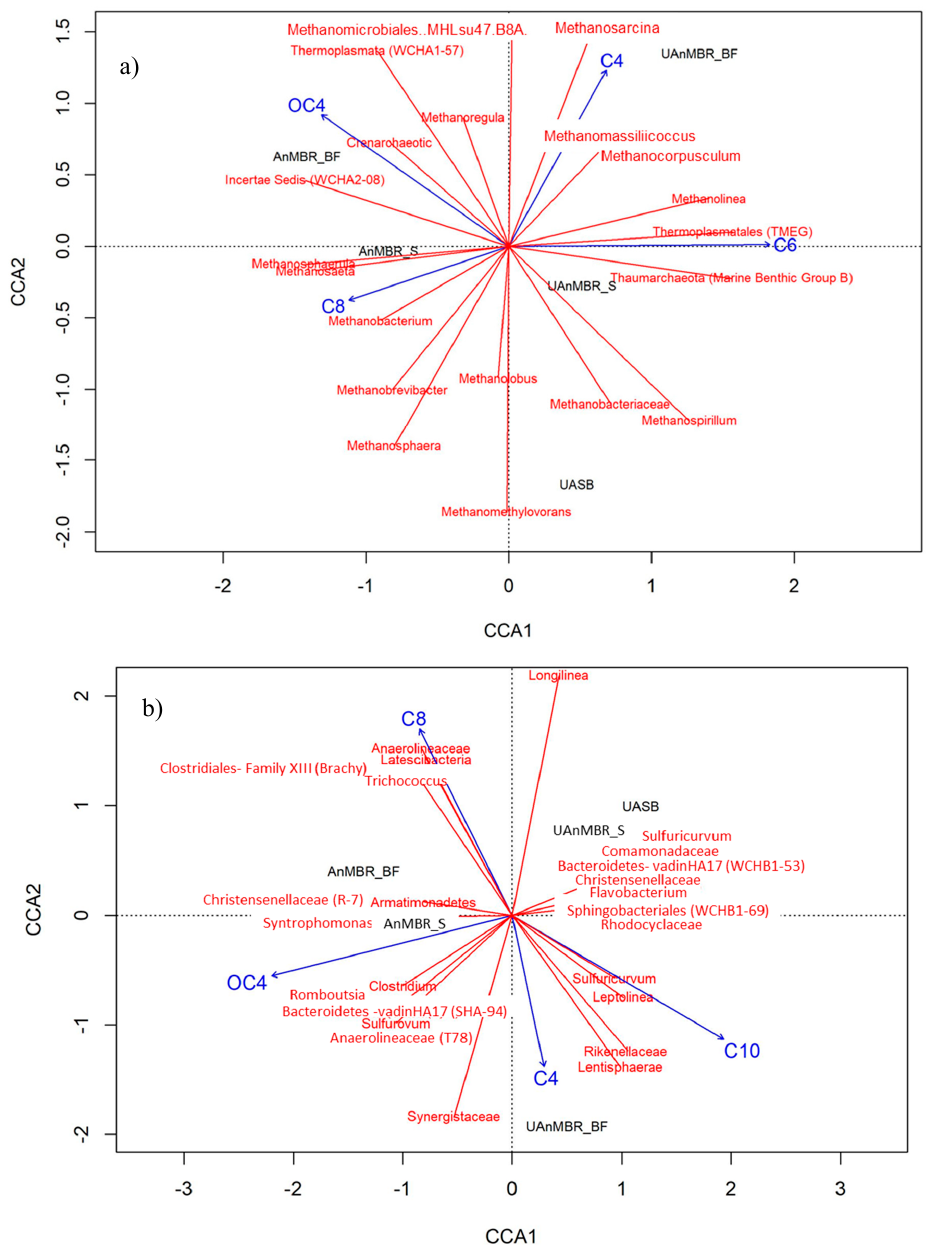
Figure 5. Canonical correspondence analysis (CCA) of acyl homoserine lactones (AHL) concentrations with ( a ) all archaea and b ) the 30 most abundant bacteria. AnMBR_BF is the biofilm from AnMBR, AnMBR_S is the sludge from AnMBR, UAnMBR_BF is the biofilm from UAnMBR, and UASB represents sludge from the UASB. AHL abbreviations are as follows; C4: C4 ‐ HSL; C6: C6 ‐ HSL; C8: C8 ‐ HSL; C10: C10 ‐ HSL; C12: C12 ‐ HSL; OC4: 3 ‐ oxo ‐ C4 ‐ HSL; OC6: 3 ‐ oxo ‐ C6 ‐ HSL; OC8: 3 ‐ oxo ‐ C8 ‐ HSL; OC10: 3 ‐ oxo ‐ C10 ‐ HSL; OC12: 3 ‐ oxo ‐ C12 ‐ HSL.